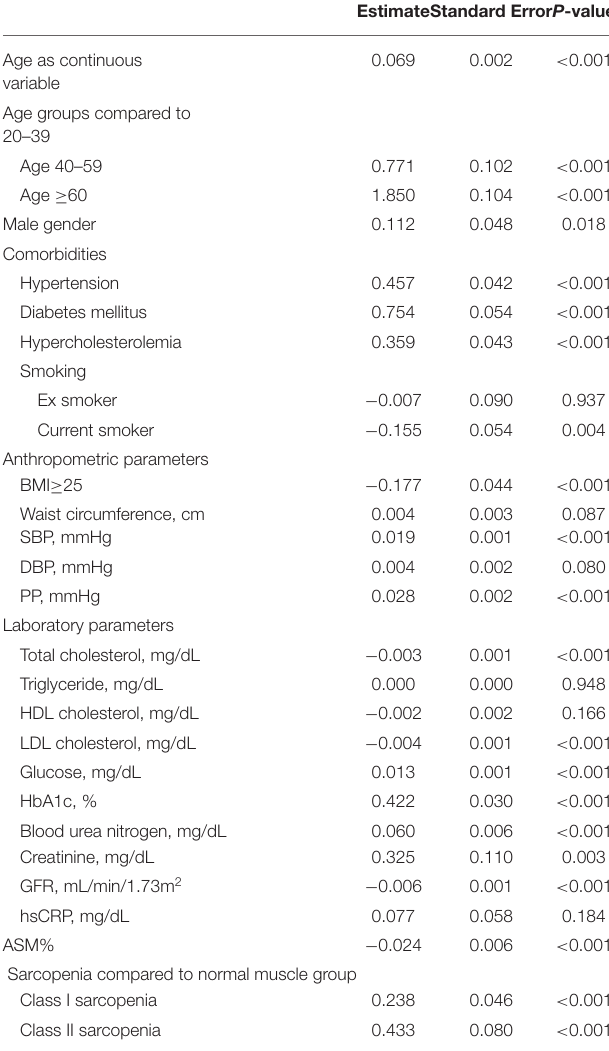
EstimateStandard Error P